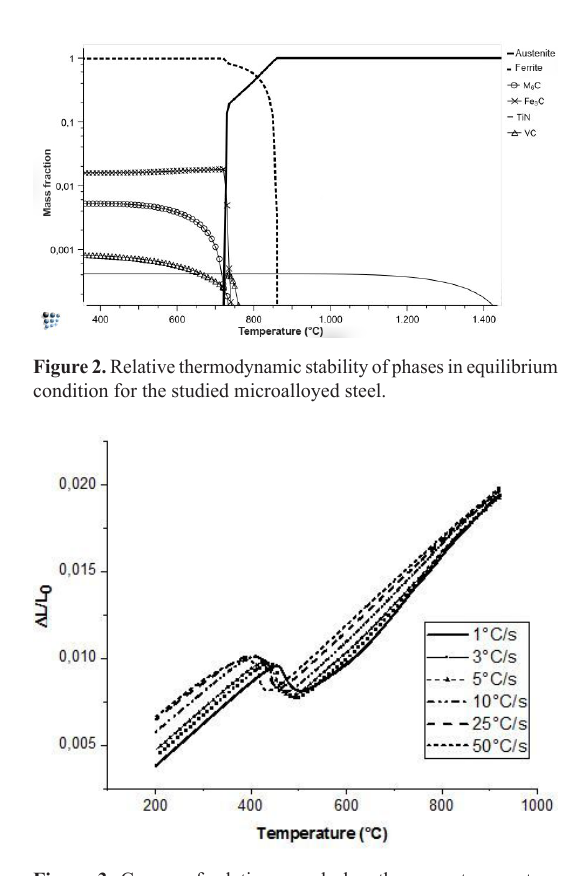
Figure 3. Curves of relative sample length versus temperature for samples austenitized at 920°C and cooled with different rates.